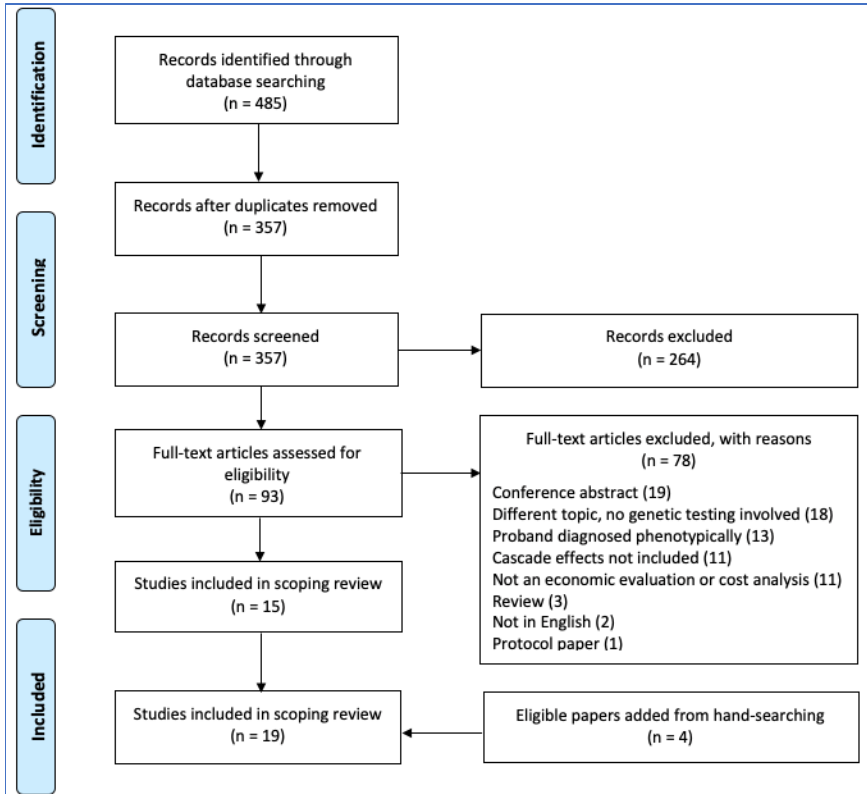
Figure 1. PRISMA flow diagram.